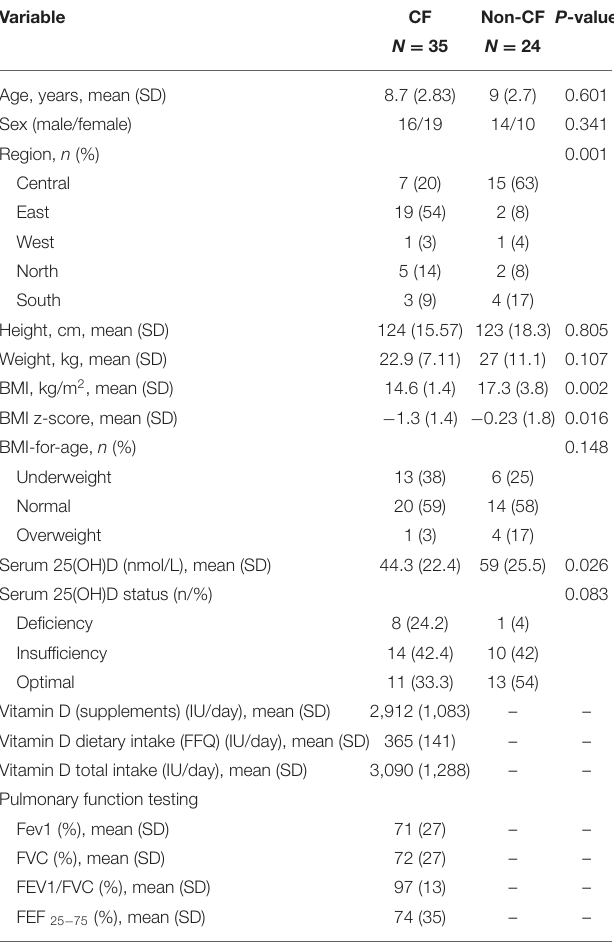
TABLE 2 | Study participant characteristics.